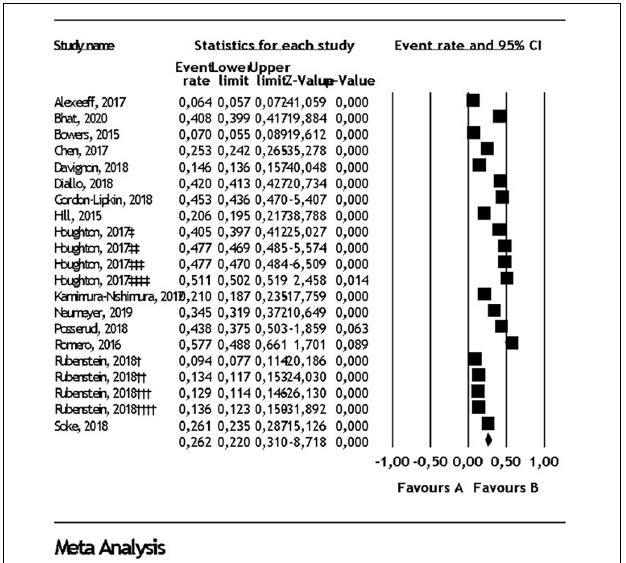
FIGURE 4 | Anxiety disorder comorbidity in autism spectrum disorder. Diamond represents the random effect model analysis result for the meta-analysis of 19 subgroups given in 11 studies ( † : 5-11 years old in commercial data, †† : 12-17 years old in commercial data, ††† : 5-11 years old in Medicaid data, †††† : 12-17 years old in Medicaid data, ∼ 6-11 years old, ∼∼ 12-17 years old, ‡ : 2002 ADDM data, ‡‡ : 2006 ADDM data, ‡‡‡ : 2008 ADDM data, ‡‡‡‡ : 2010 ADDM